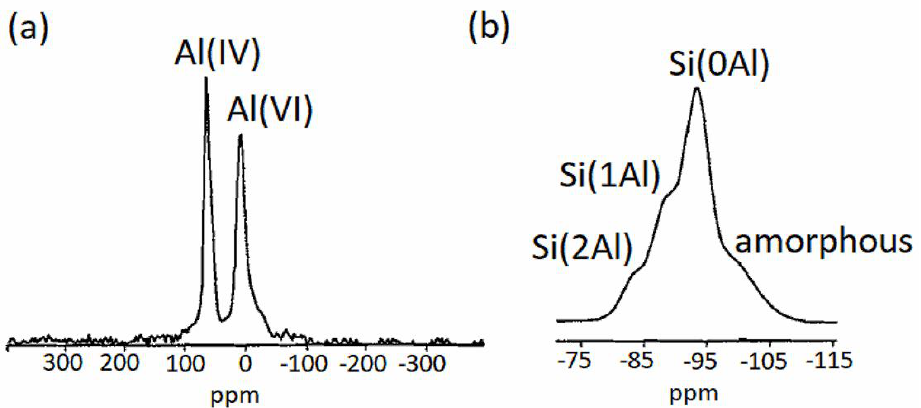
27 A1 magic-angle-spinning nuclear magnetic resonance (MAS-NMR) spectrum of synthetic NH Figure 10 Figure 10. ( a ) and ( b ) 29 Si MAS-NMR spectrum of synthetic NH 4 -saponite (modified from